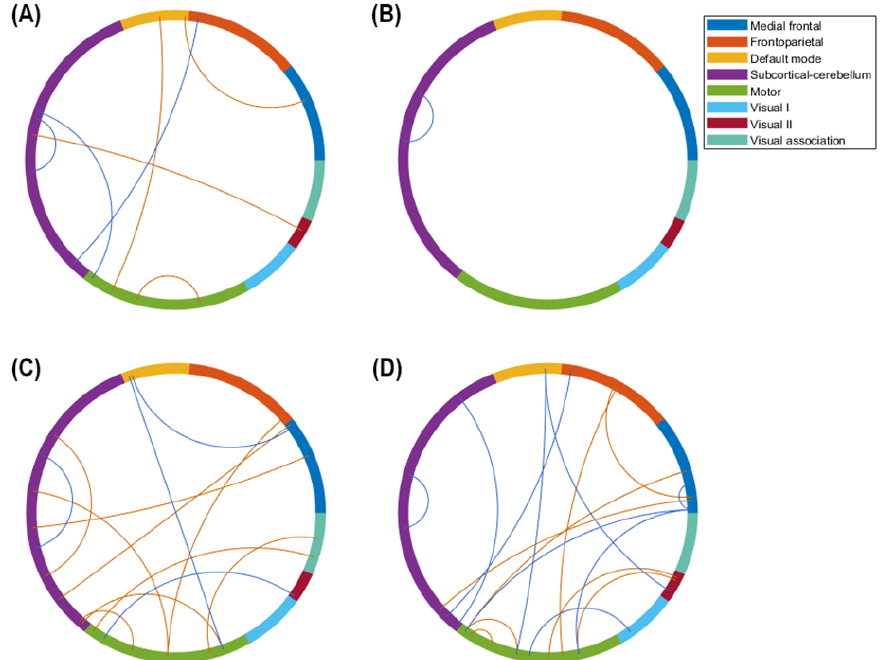
Figure 3. Major features of the prediction models for the changes in symptom and functioning scores. By using the least absolute shrinkage and selection operator 100 times, we bootstrapped the data of 90% of the patients and the selected features. The number of features selected was similar to but fewer than the sample size for training the support vector regression models. The illustration uses the eight networks of Shen’s 268-region parcellation. ( A ) Major features of the regression for the Montgomery–Åsberg Depression Rating Scale. ( B ) Major features of the regression for the UKU Side Effects Rating Scale. ( C ) Major features of the regression for the Young Mania Rating Scale after the removal of strong outliers. ( D ) Major features of the regression for the Positive and Negative Syndrome Scale after the removal of strong outliers. The red line represents the connectivity that is positively correlated with the changes in symptom and functioning scores, and the blue line represents the connectivity that is negatively correlated with the changes in symptom and functioning scores. Table 3. Major features of the prediction models for the changes in symptom and functioning scores.